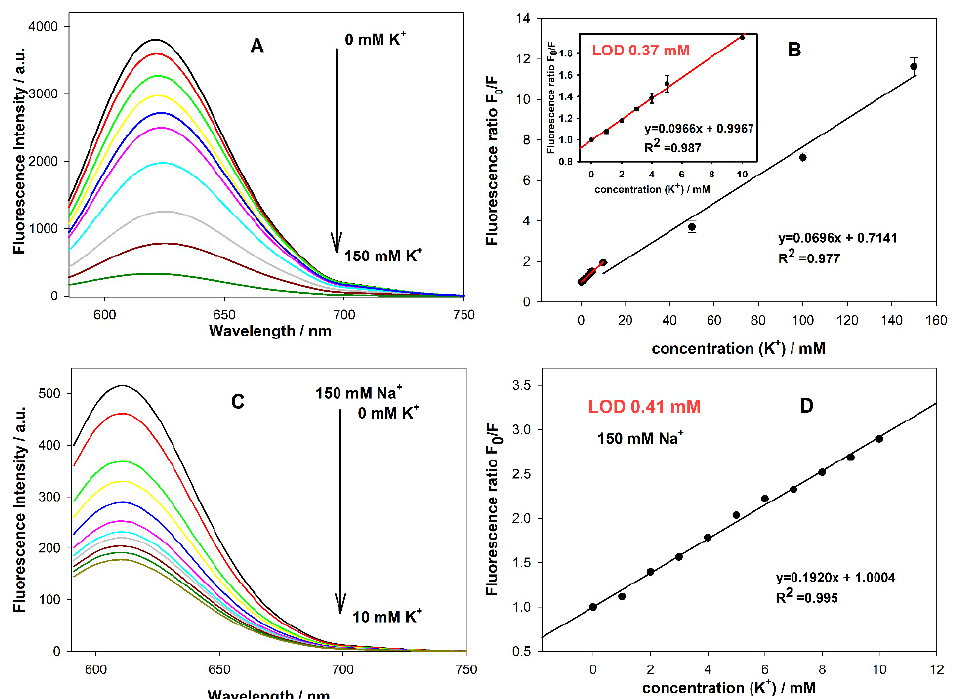
Figure 8. Fluorescence response of the Tel22C12-AgNCs in buffers w/o and with sodium ions at different K + concentrations: ( A ) the emission spectra of Tel22C12-AgNCs upon adding increasing concentrations of K + ions (0–150 mM) and ( B ) corresponding Stern–Volmer plot showing K + quench- ing effect on Tel22C12-AgNCs emission spectra with λ max = 620 nm in the absence of sodium ions. Insert showing linear relationship in concentration ranges from 0 to 10 mM K + ; ( C ) the emission spectra of Tel22C12-AgNCs in buffer with 150 mM NaCl upon adding increasing concentrations of K + ions (0–10 mM) and ( D ) corresponding Stern–Volmer plot showing K + quenching effect on Tel22C12-AgNCs emission spectra with λ max = 610 nm in the presence of sodium ions. Conditions: 2 µ M probe in 10 mM Tris-acetate (pH = 7.5) after 24 h from silver reduction in buffer w/o metal